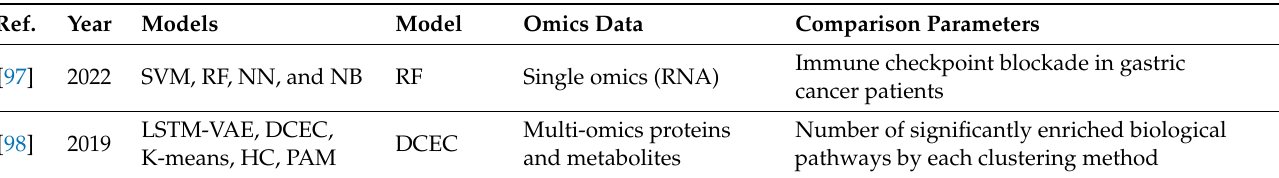
Table 6. Comparative studies in omics